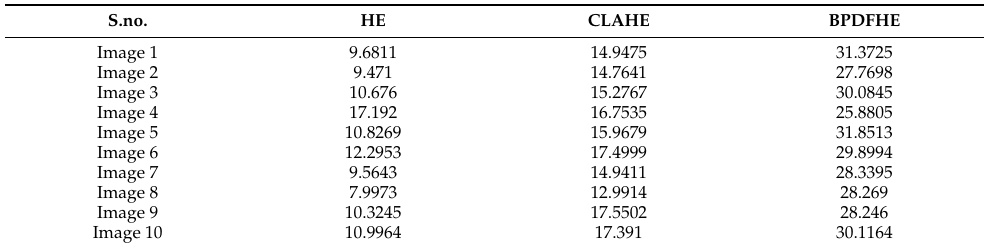
Table 2. Comparison of PSNR values.